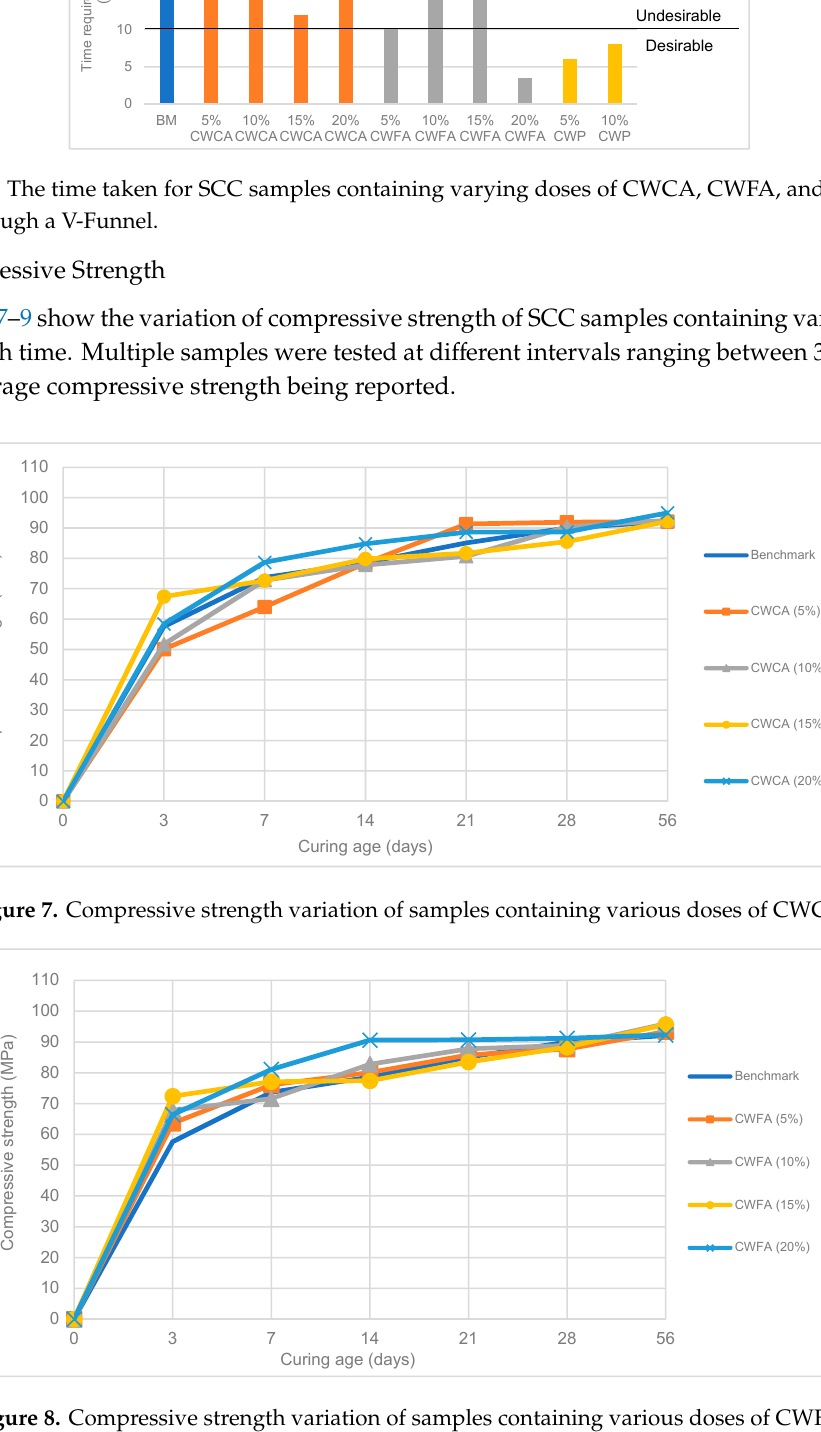
Figure 8. Compressive strength variation of samples containing various doses of CWFA.